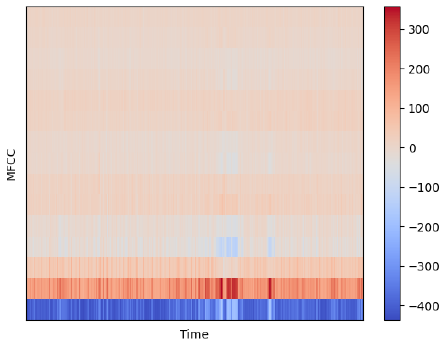
Figure 3. Mel-frequency cepstral